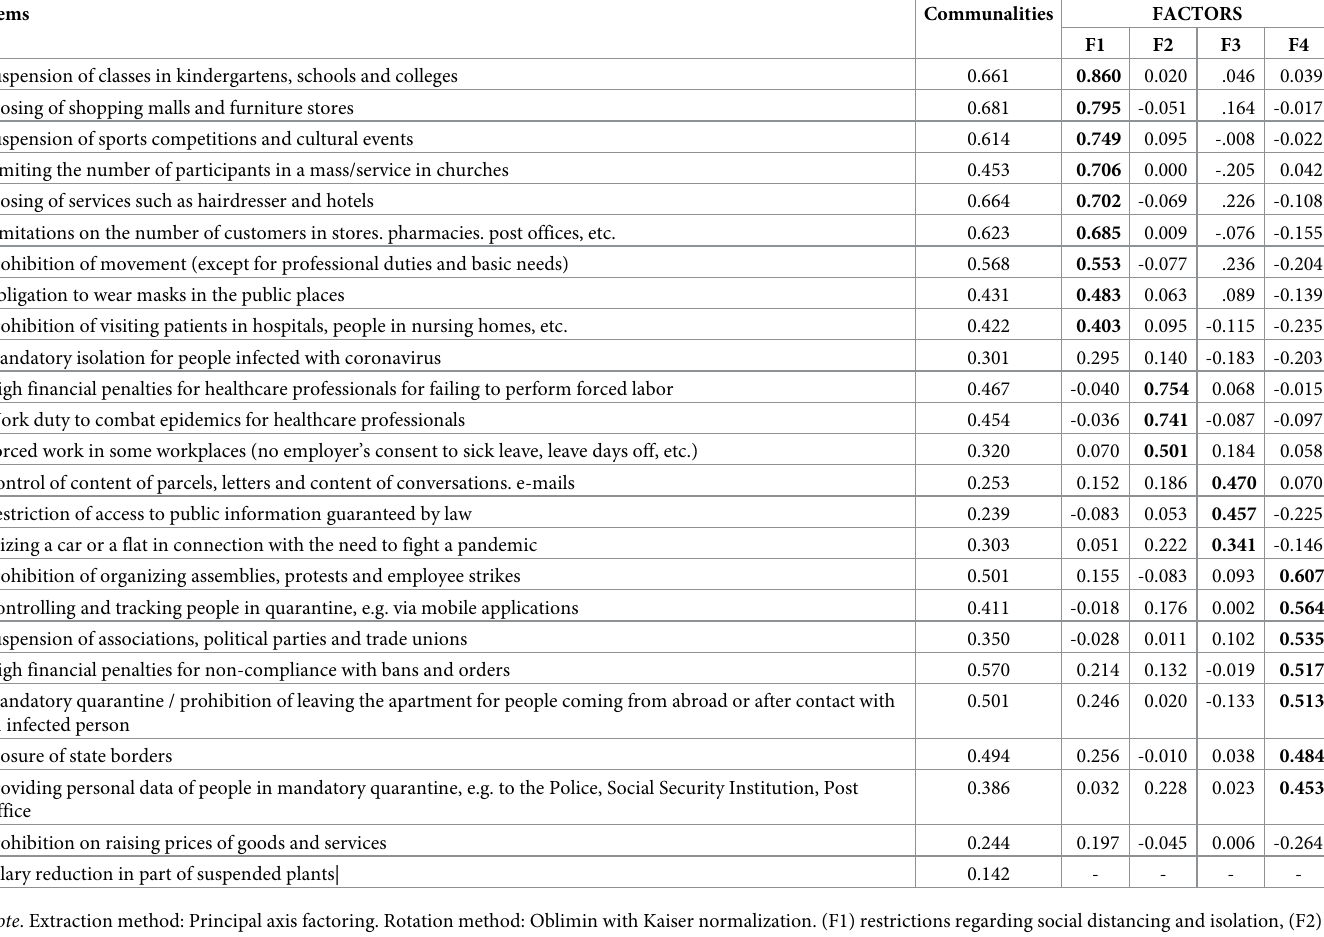
Table 1. Factor loadings and communalities of the items measuring the acceptance of the pandemic-related